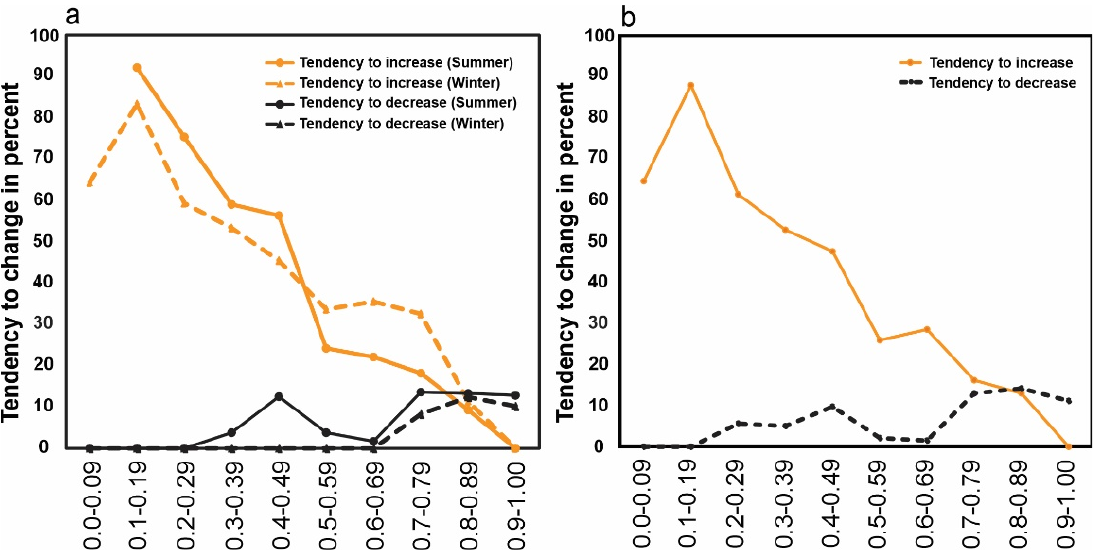
Figure 7. The tendency to change the lighting level on categorized measured DTR. Separated by season ( a ) in general ( b ). Extreme outliers are marked with an asterisk and circles.